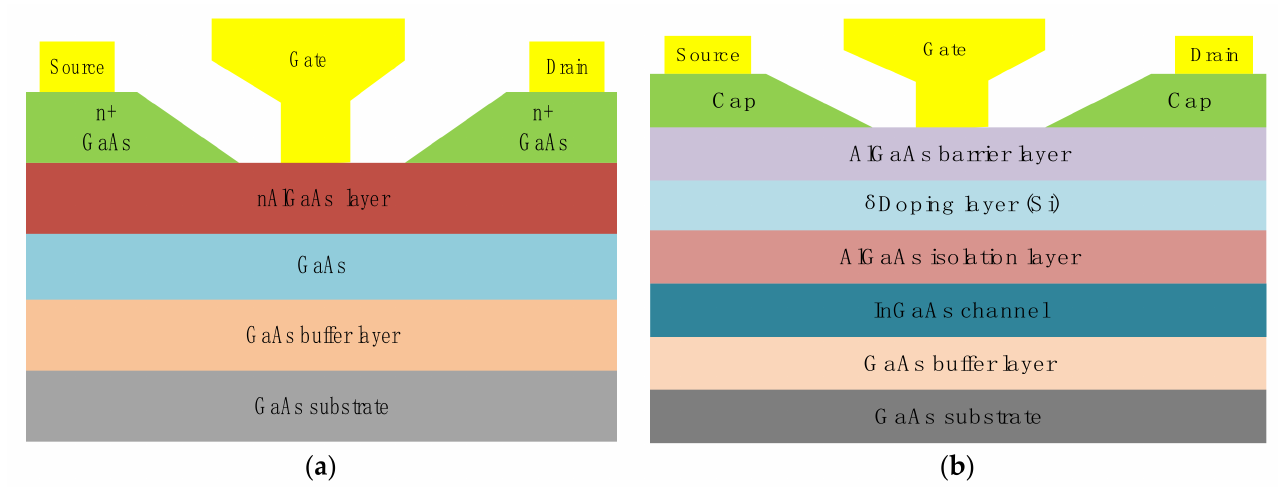
Figure 2. ( a )Traditional GaAs HEMT structure profile, ( b ) GaAs pHEMT